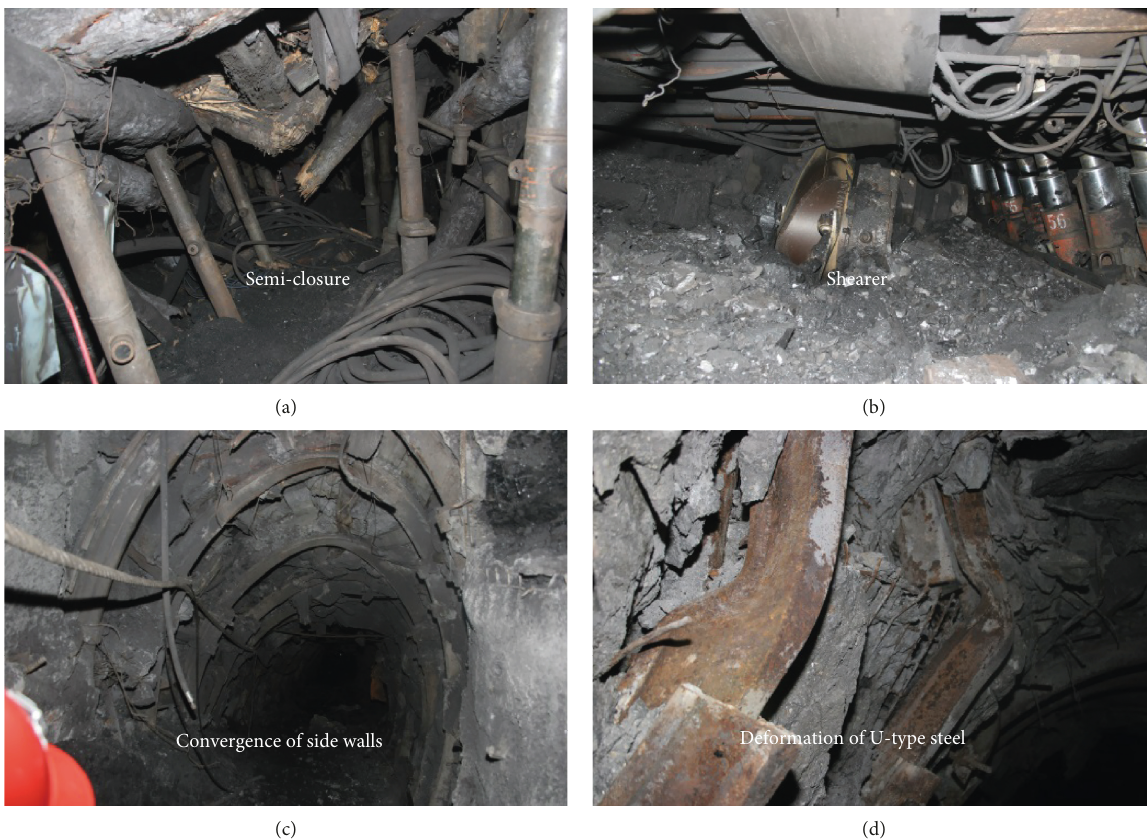
Figure 2: Photos of rockburst damage in Xing’an Coal Mine, roof subsidence and floor heave (a), coalface damage (b), convergence of two side walls (c), and damage of U-type steel (d).